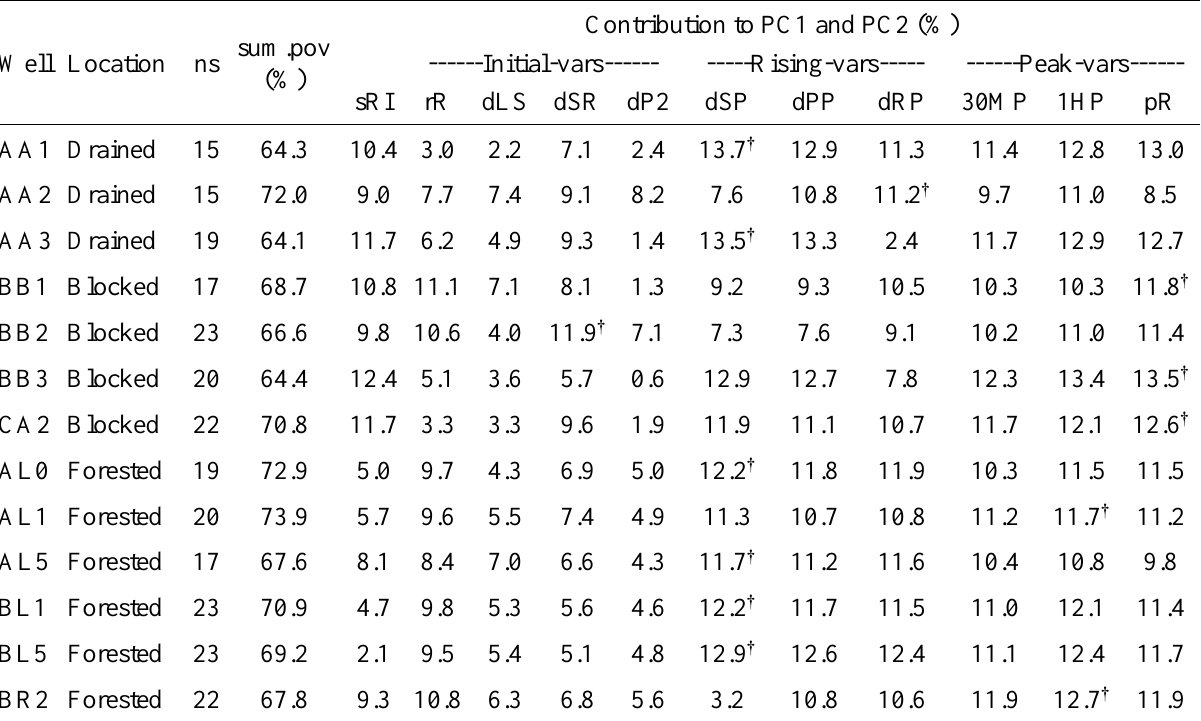
Table 3. The contributions of storm variables to Principal Components 1 and 2 (PC1 and PC2) at individual wells, during the shallow water-table conditions. The codes are explained in Table 1. Column ns contains the number of storms considered. Column sum.pov contains the variances of the response to storms that are represented by PC1 and PC2. For each well, storm variables with the largest contributions are indicated by † .